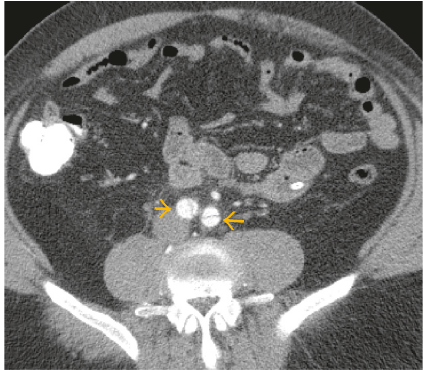
Figure 3: CT angiography showing acute type B aortic dissection extending into the proximal common iliac arteries (yellow arrows). This parallels with the patient’s clinical complaints of scrotal pain and dysuria.